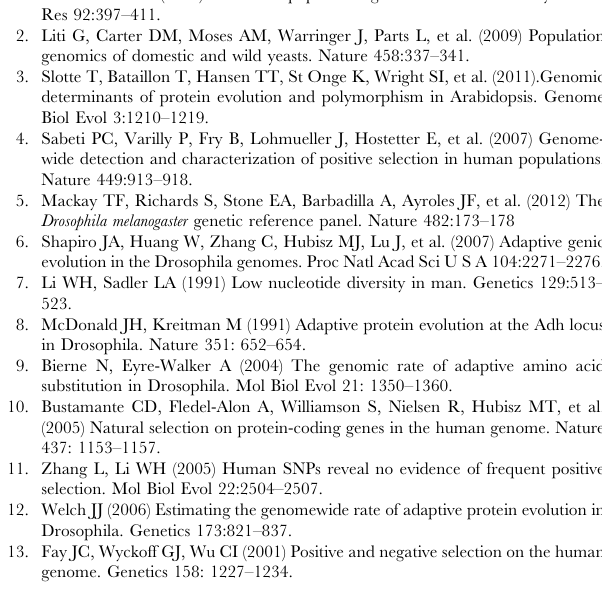
Figure S3 Between-individual geographic versus genetic distances. Each dot is for a pair of individuals. X-axis: geographic distances in km; Y-axis: genetic distance, defined as (H b 2 H w )/H w , where H b is the probability of drawing two distinct alleles when sampling one copy from each of the two considered individuals, and H w is the average heterozygosity of the two considered individuals.